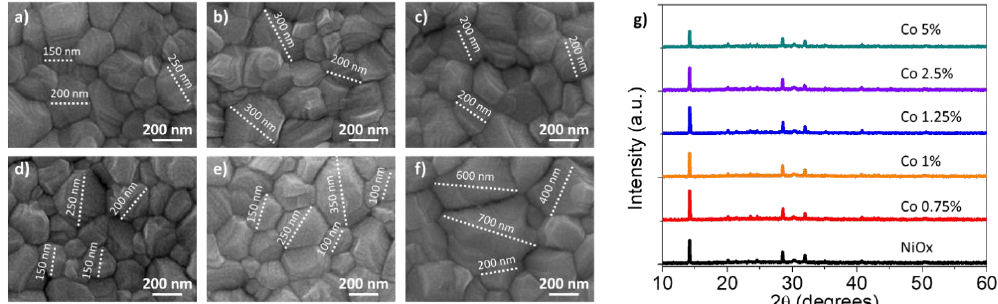
Figure 4. Scanning electron microscopy (SEM) images of the NiO x and Co-NiO x films on glass substrate. ( a ) NiO x ; ( b ) 0.75 mol% Co-NiO x ; ( c ) 1 mol% Co-NiO x ; ( d ) 1.25 mol% Co-NiO x ; ( e ) 2.5 mol% Co-NiO x ; ( f ) 5 mol% Co-NiO x .